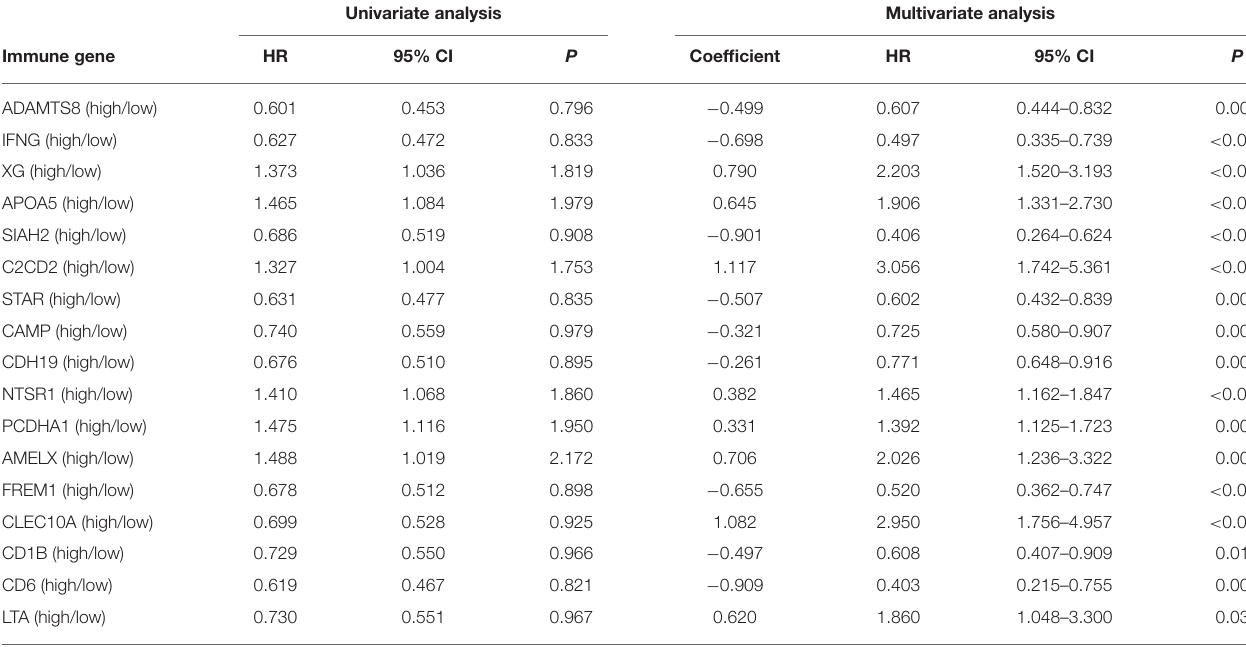
TABLE 2 | Information of prognostic immune genes.